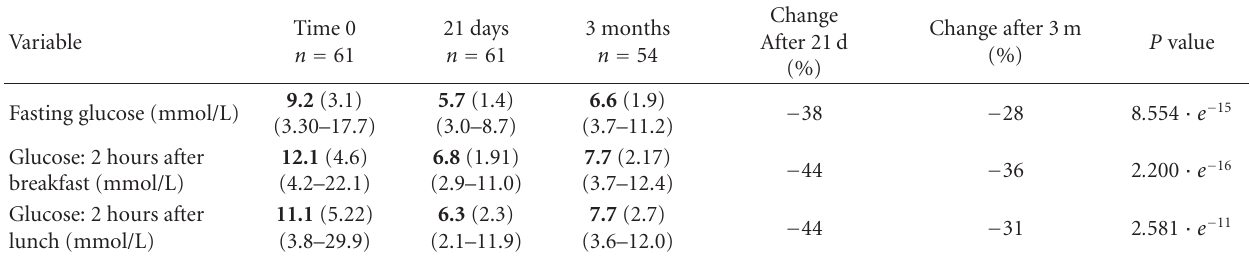
Table 4: Glycemic profile evolution during 3-month intervention with Ma-Pi 2 diet in type 2 diabetic adults.